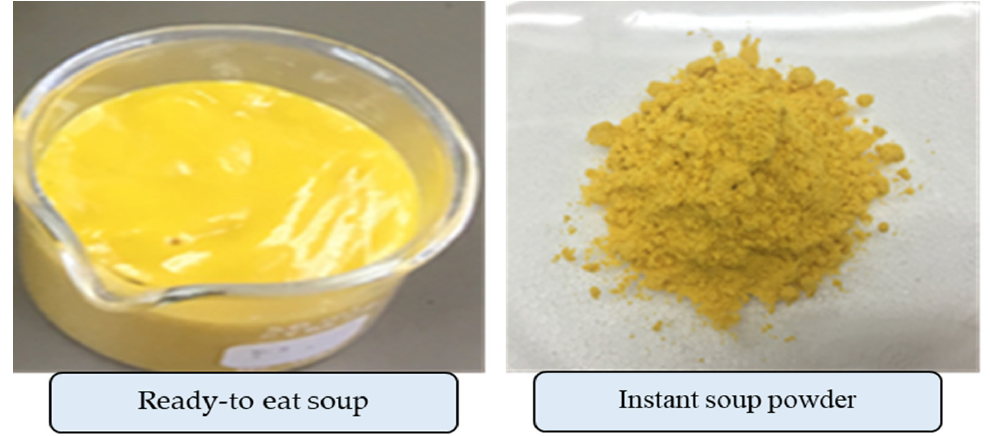
Figure 1. Photographs of Ready-to-eat soup and instant soup powder. Table 5. Proximate, physicochemical, and microbiological quality of dehydrated soup powder and reconstituted soup for the elderly.